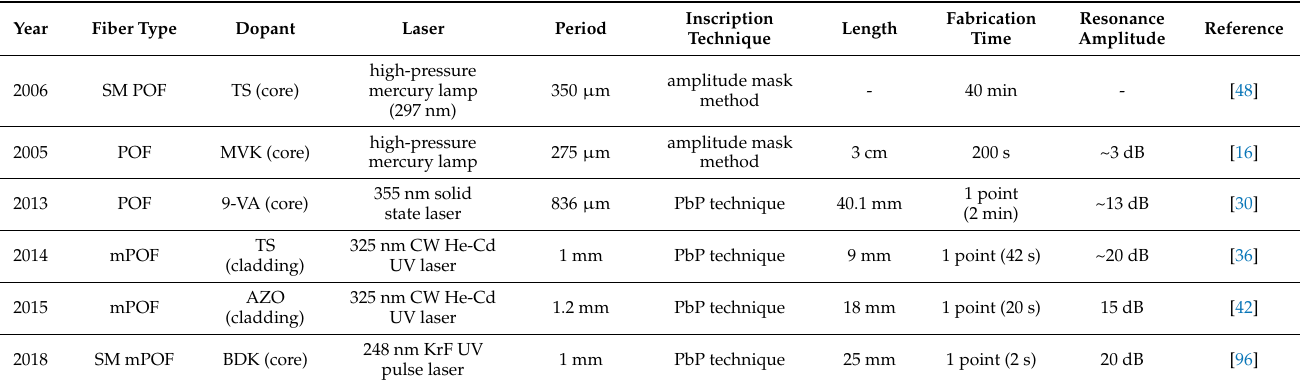
Figure 20. Experimental set-up for inscribing LPFGs in photosensitive POF [30,36]. In 2015, Kowal et al., used the same inscription technique to inscribe a LPFG with 15 dB resonance depth in a PMMA POF with a cladding doped with AZO [42]. In 2018, Min et al. [96] achieved a breakthrough in the efficiency of LPFG inscription with 2 s irradiation for one point, and a 20 dB LPFG was fabricated in a BDK-doped SM mPOF. The experimental set-up is similar to [30] with one side illumination. The detailed inscription of LPFG can be seen in Table 3. Table 3. The detailed inscription of LPFG in doped POF.